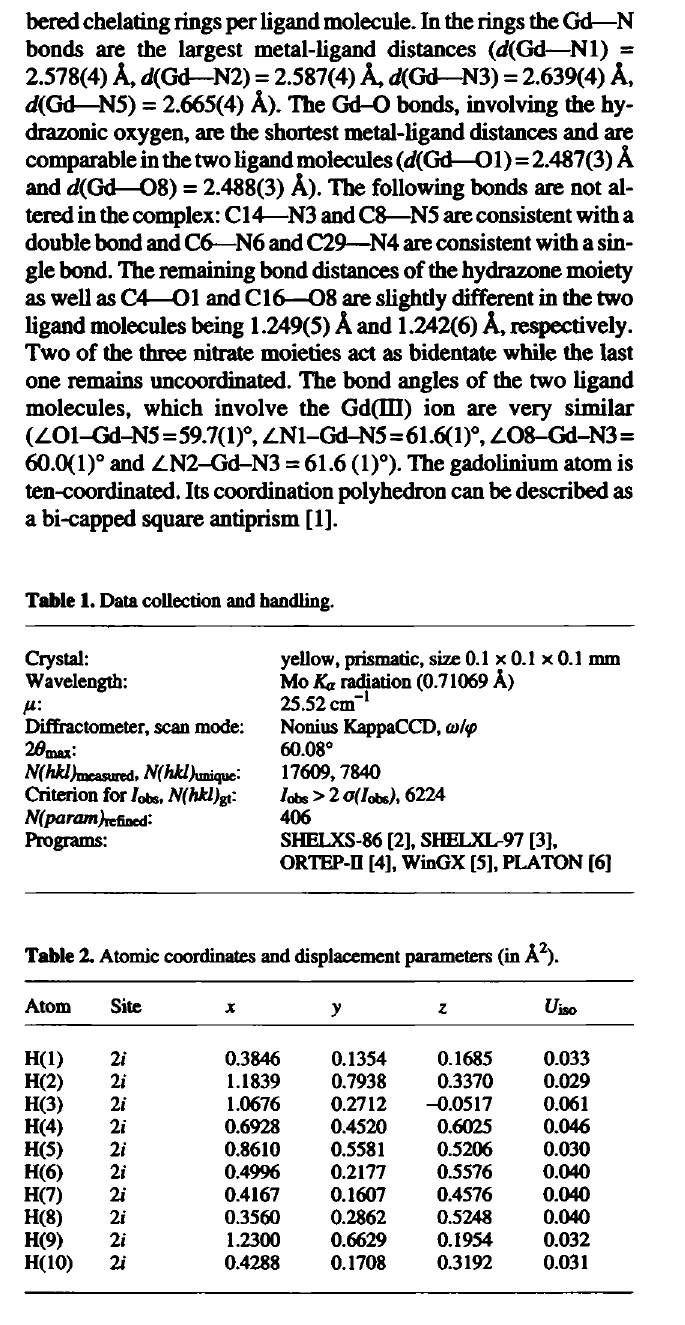
Table 2. Atomic coordinates and displacement parameters (in A 2